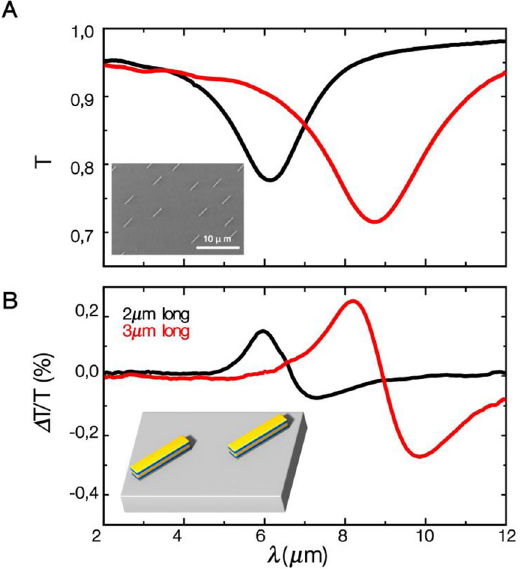
Figure 11: MRE mediated magnetic modulation of rods localized plasmons inthemidIR. (A)Transmissionspectrafor randomarraysof rods fabricated on a Ni 81 Fe 19 /Au multilayer with 3.8 % GMR, for two differentrodlengths2 μ m(blackline)and3 μ m(redline),respectively. The rodwidthis in both cases 0.3 μ m. Light is polarizedalongthe rod longaxisandthedipsinthetransmissioncorrespondtotheexcitation of the rod localized plasmon resonance. The inset shows an SEM image of the 3 μ m rod array. (B) MRE spectra ( Δ T/T=(T P -T AP )/T AP ) for the same rod arrays (black line: 2 μ m long rods, red line: 3 μ m long rods). Light is polarized along the rod long axis. The spectra show a derivative like features at the position of rod resonances. The inset shows a schema of the Ni 81 Fe 19 /Au multilayer